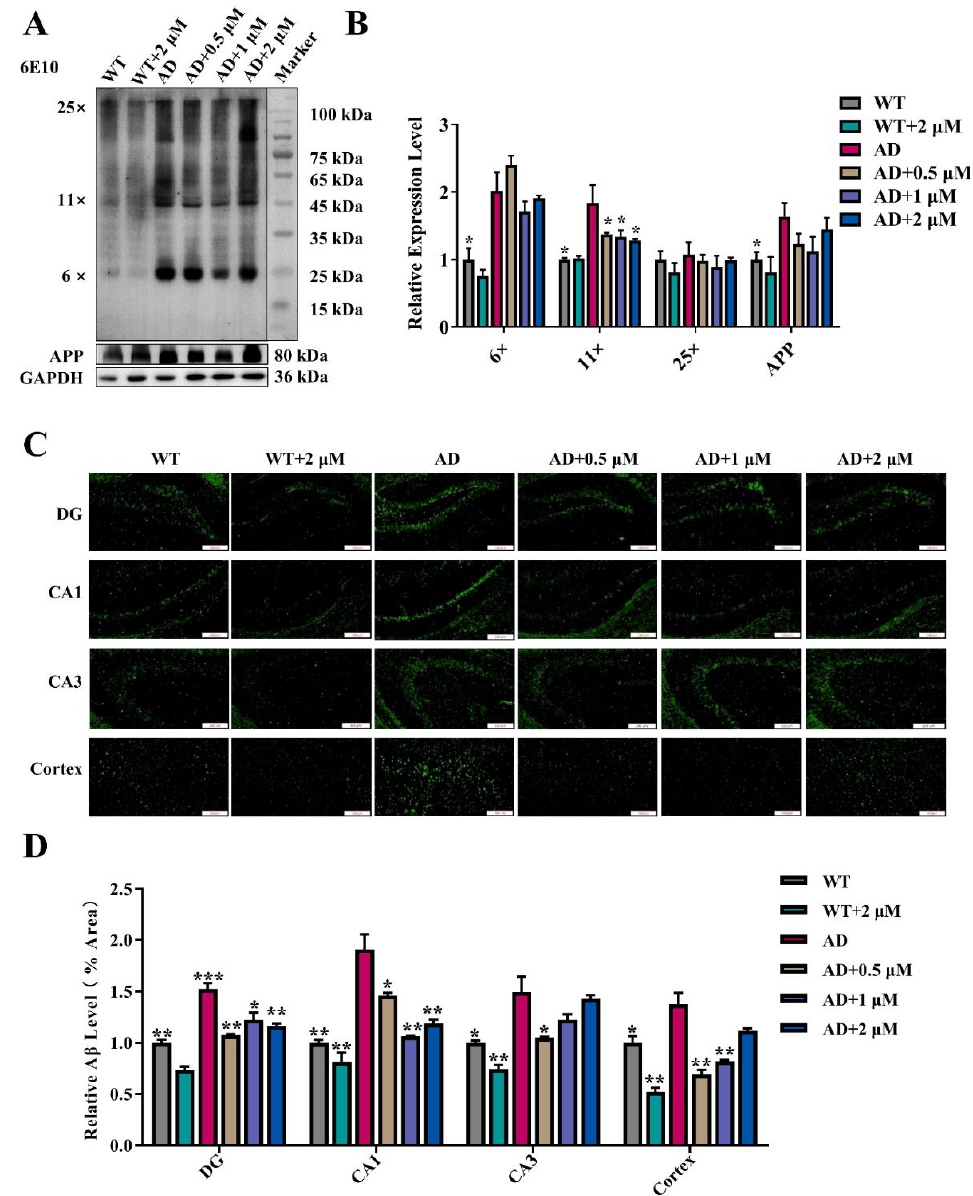
Figure 4. Ebselen inhibited Aβ pathologies in AD mice brains: ( A , B ) Representative Western blot analysis of va rious Aβ oligomers ( 6×, 11×, and 25×) and APP. The quantitative results were normal- ized by GAPDH. ( C ) Thioflavin T staining to detect the level and distribution of amyloid plaques in brain ti ssues (Scale bar: 200 μm); ( D ) quantitative analysis of thioflavin T staining. (* p < 0.05, ** p < 0.01, *** p < 0.001 vs. AD group; n = 3).